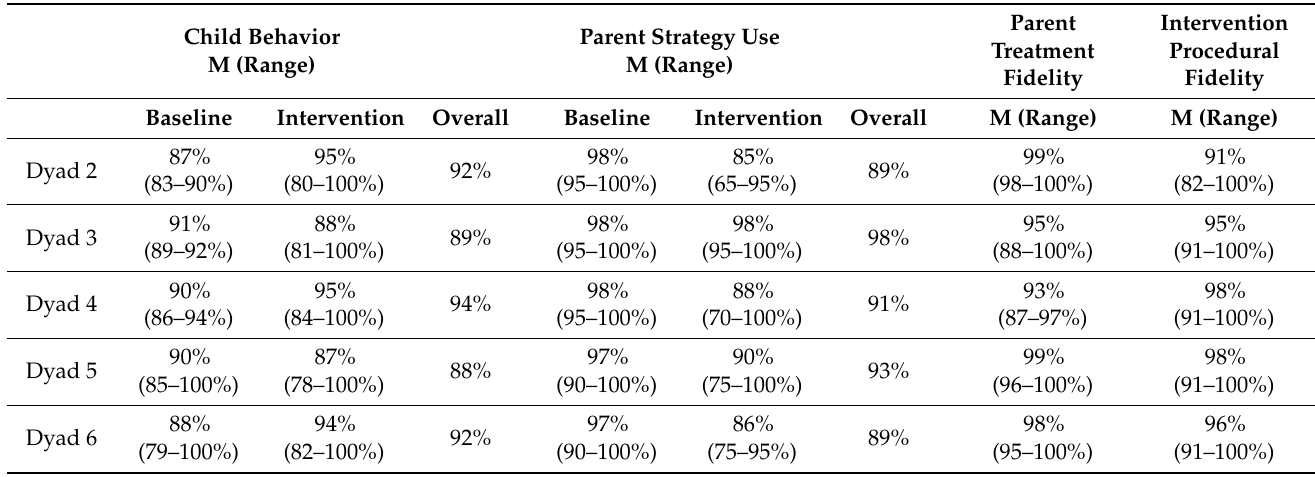
Table 5. Reliability of Child Behavior, Parent Strategy Use, Parent treatment Fidelity and Intervention Procedural Fidelity. Child Behavior Parent Strategy M (Range)